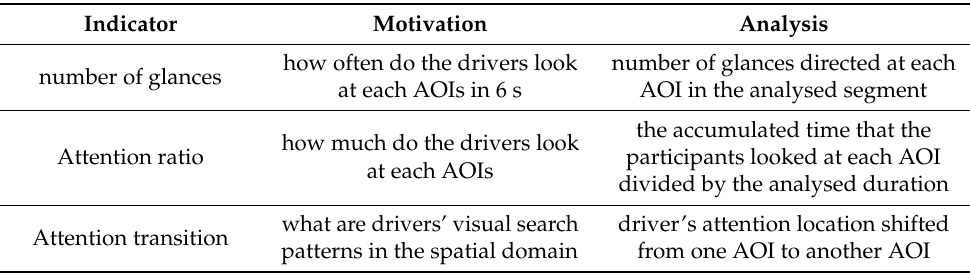
Table 1. Description of motivation and analysis of the three indicators of visual behaviour in this study. Indicator Motivation Analysis how often do the drivers look number of glances directed at each number of glances at each AOIs in 6 s AOI in the analysed segment the accumulated time that the how much do the drivers look participants looked at each AOI Attention ratio at each AOIs divided by the analysed duration what are drivers’ visual search driver’s attention location shifted Attention transition patterns in the spatial domain from one AOI to another